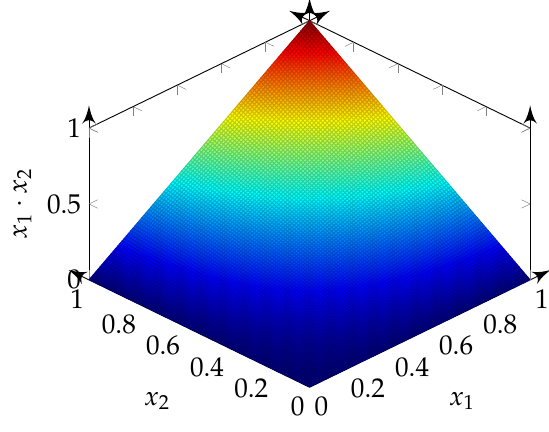
Figure 7. Results of the function x 1